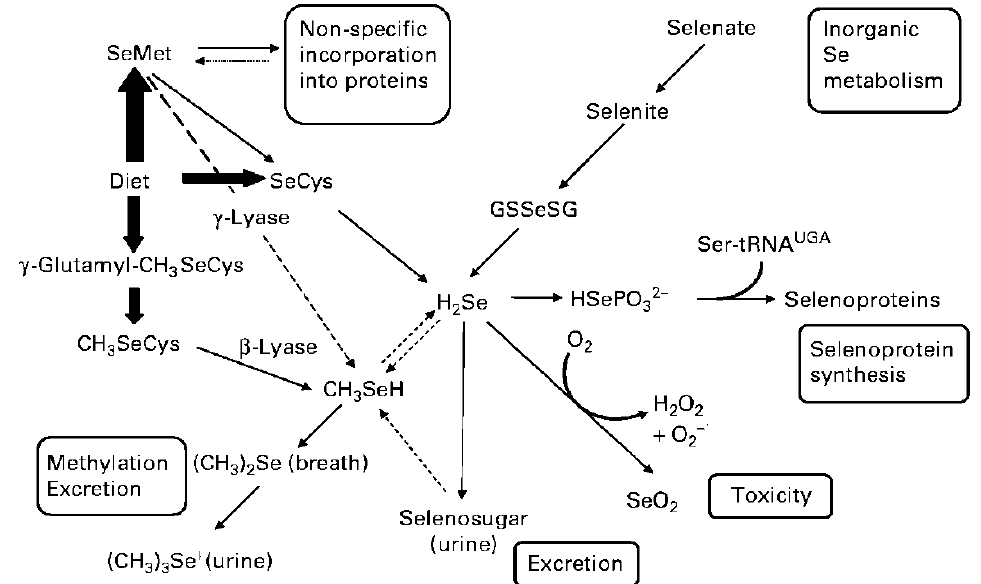
Figure 1. Metabolic pathway of dietary selenium (Se) in humans. Reproduced with permission from